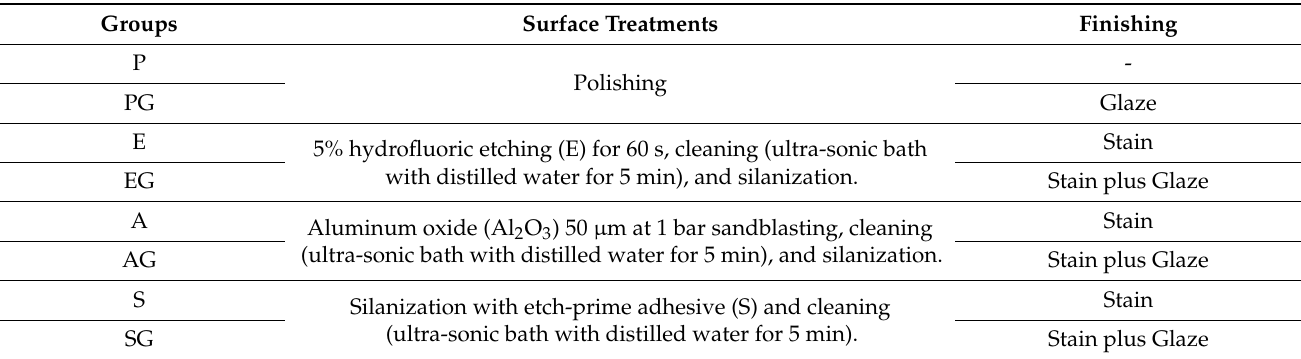
Table 2. Experimental